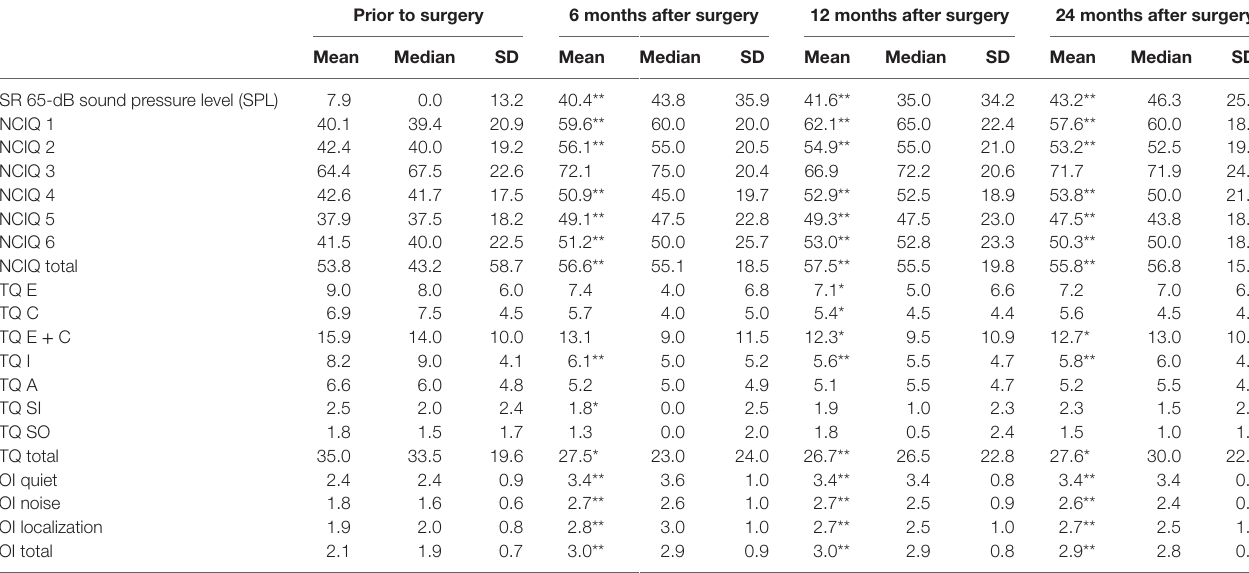
TaBle 3 | changes in parameters measured as compared to their values prior to cochlear implantation. Prior to surgery 6 months after surgery 12 months after surgery 24 months after